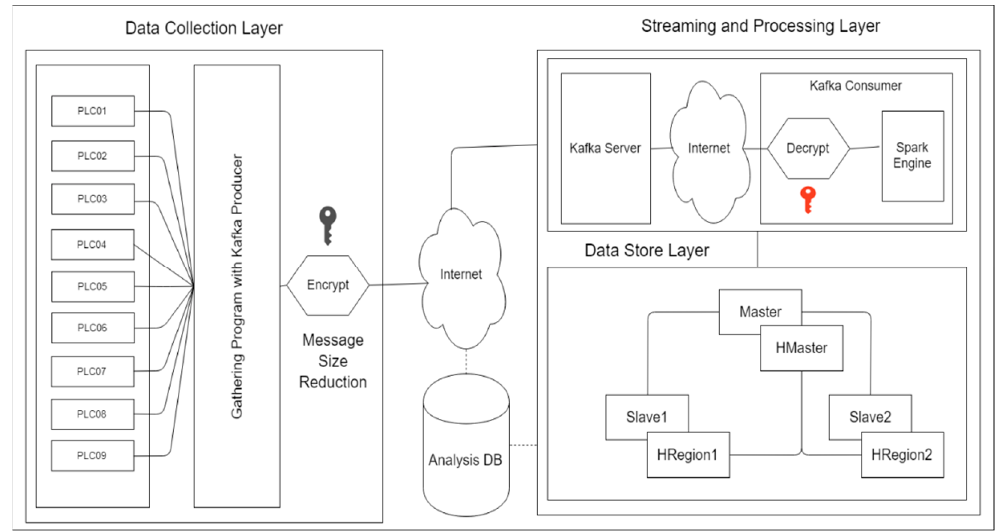
Figure 1. System Architecture and Flow.